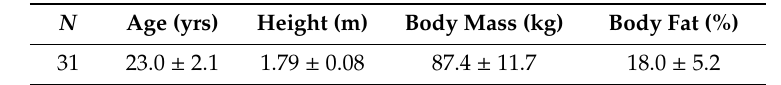
Table 1. Demographic and anthropometric measurements of participants included in the final data